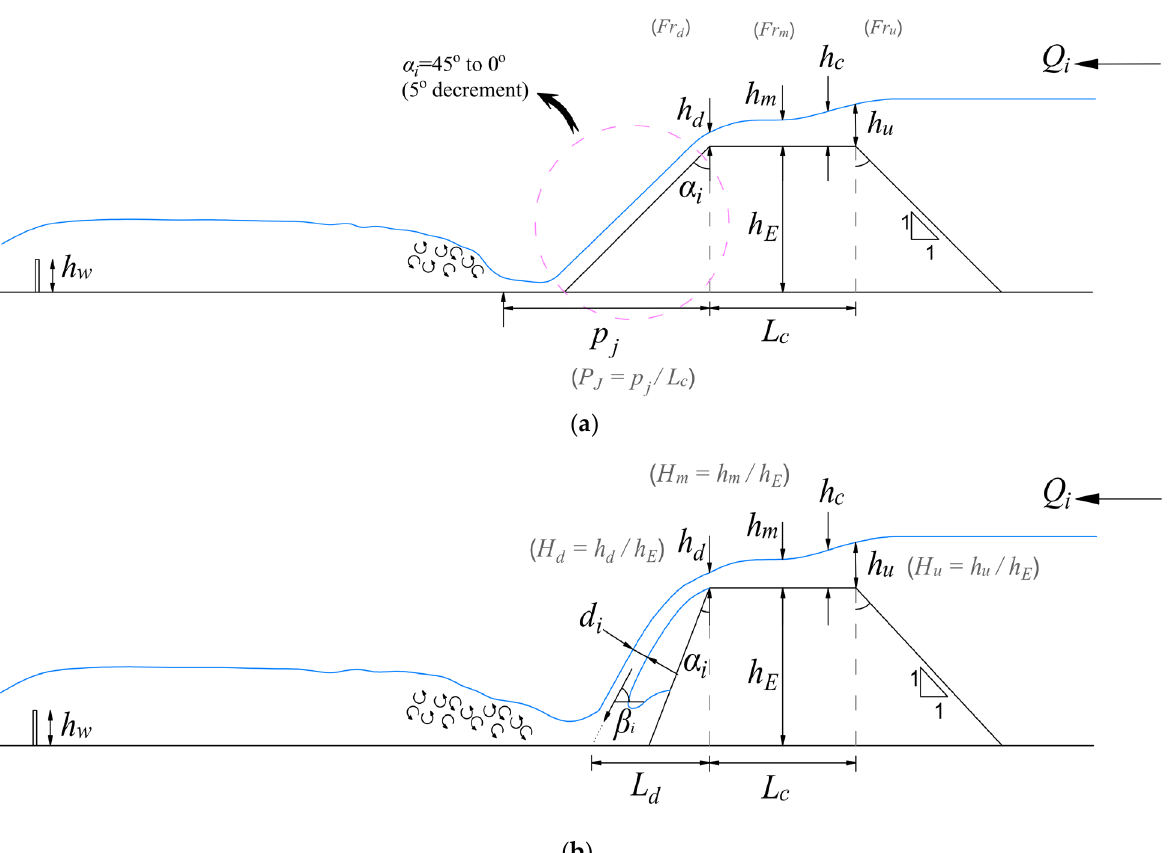
Figure 3. Sketch of the experimental setup with nappe flow formation: ( a ) model setup inside the flume without the vegetation over the crest of EM, ( b ) schematic of formation of nappe flow without vegetation model over the crest of EM.